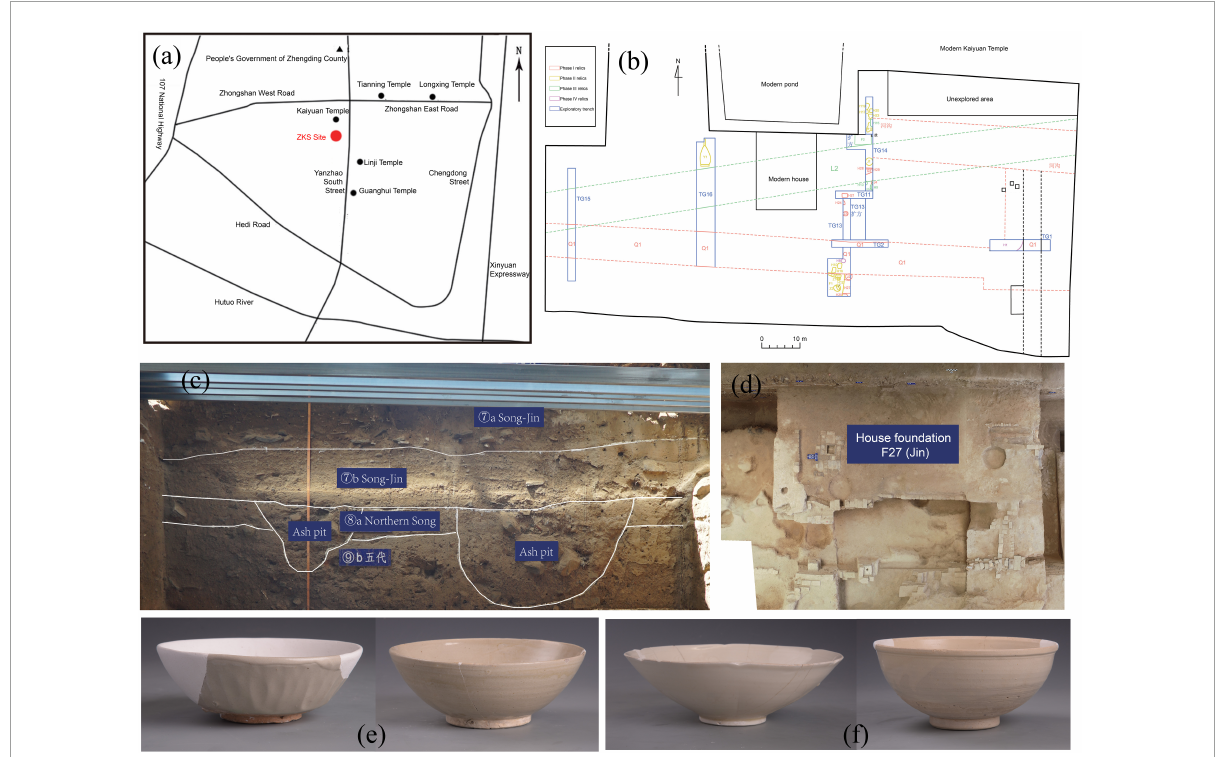
FIGURE2 Images of the archeological sites and their cultural relics. (a) Location map of ZKS site; (b) general plan of the archaeological survey relics of the ZKS site; (c) relationship of cultural layers; (d) house foundation of F27; (e) porcelain bowls of the Northern Song Dynasty; (f) porcelain bowls of the Jin